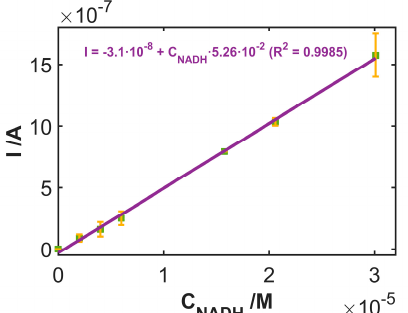
Figure 5. Calibration curve of the current intensity values from amperometric measurements polarizing the electrode at +0.30 V vs. the NADH concentration. Each point has been replicated three times using the same electrode for all measurements. Error bars account for standard